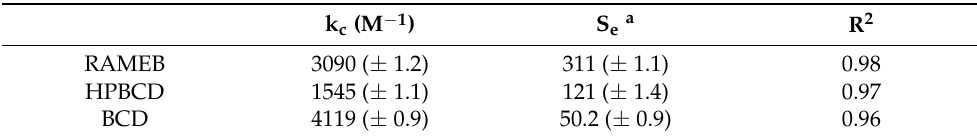
Table 5. Chlorpyrifos apparent stability constants (K c ) and solubilisation efficiency (S e ) obtained from the phase solubility